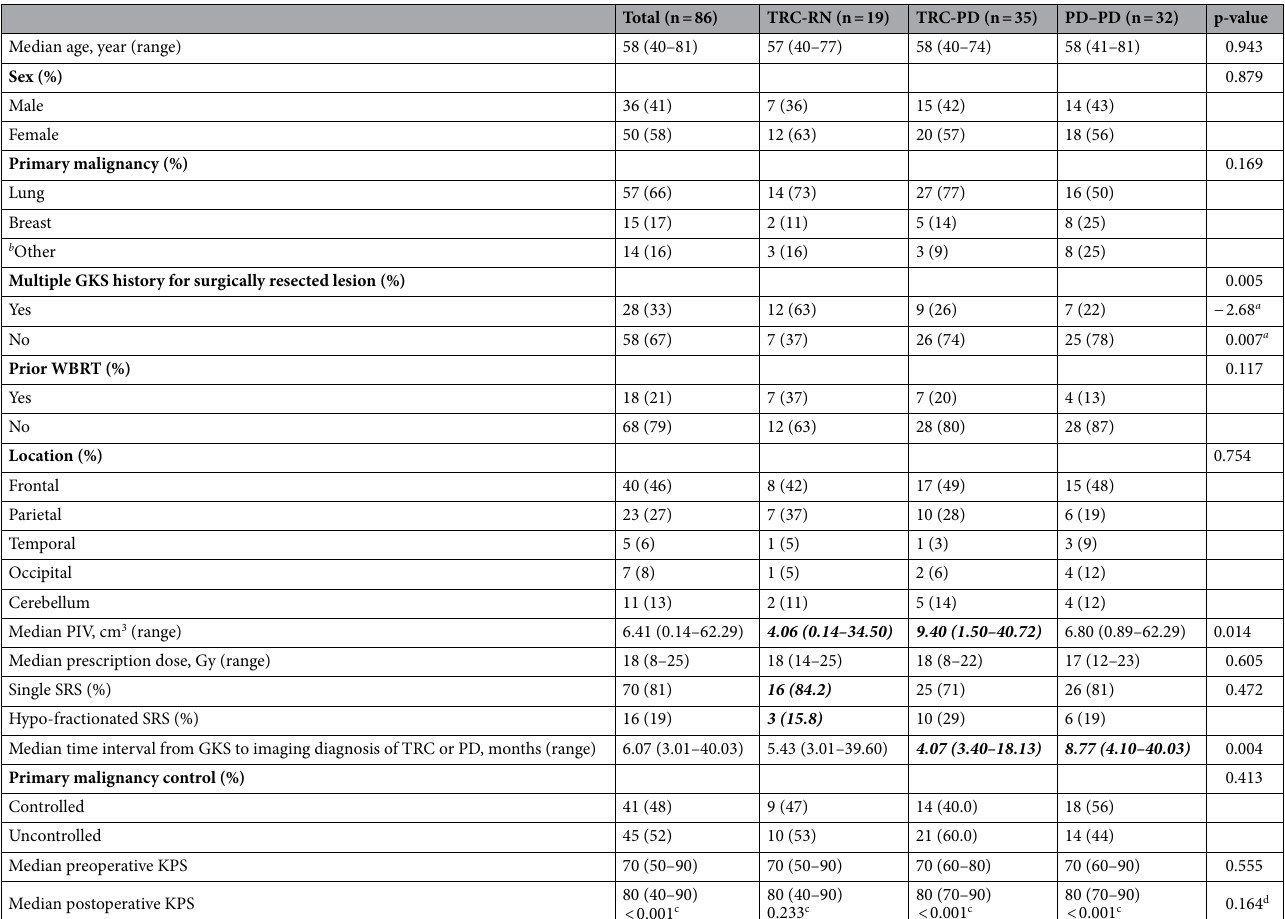
Table 1. Patient demographics and treatment parameters. The overall p-value comparing the three groups is indicated on variables. If the overall p-value was less than 0.05, post hoc test was performed to compare every two groups in pairs. The variables which showed significant differences were designated in bold italics. GKS gamma knife radiosurgery, PD progressive disease, PIV prescription isodose volume, RN radiation necrosis. a z- and p-values of the Jonckheere-Terpstra test. b renal cell cancer (3), colorectal cancer (4), melanoma (2), hepatocellular carcinoma (2), cholangiocarcinoma, endometrial carcinoma, thyroid cancer. c In each group, the p-value for the change in KPS score before and after surgery was estimated through Wilcoxon signed rank test.